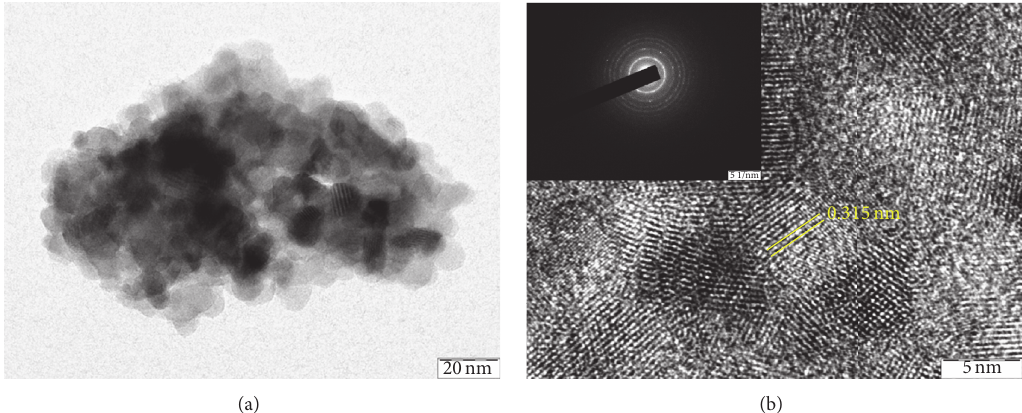
Figure 7: TEM images showing (a) spherical nature of as-synthesized CuO nanoparticles and (b) HRTEM image of CuO NPs and SAED pattern (inset